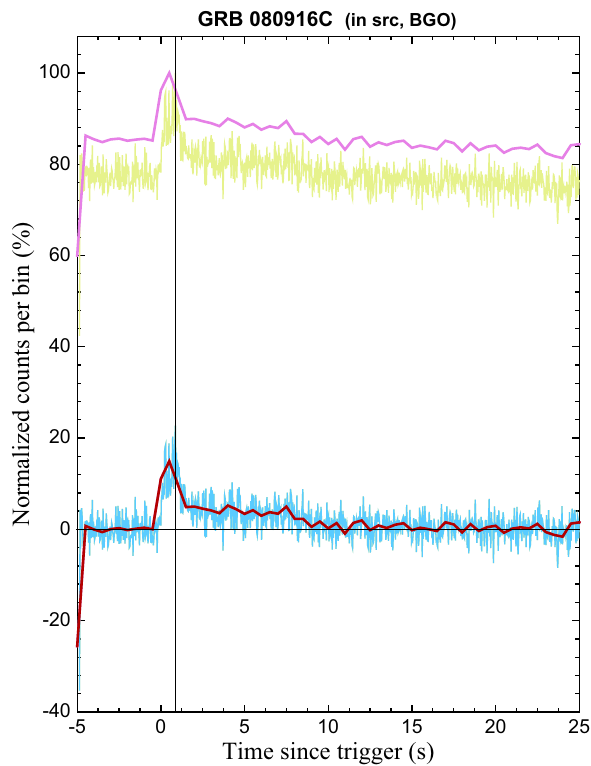
Fig. 24 BGO light curves for GRB 080916C with and without back- ground subtraction. The upper two curves refer to the light curves with- out background subtraction (also shown in Fig. 19). After subtracting thebackgroundweobtainthelowertwocurves.Thetime t low , obs /( 1 + z ) determined from the light curves with and without background subtrac- tion are the same, marked by the vertical